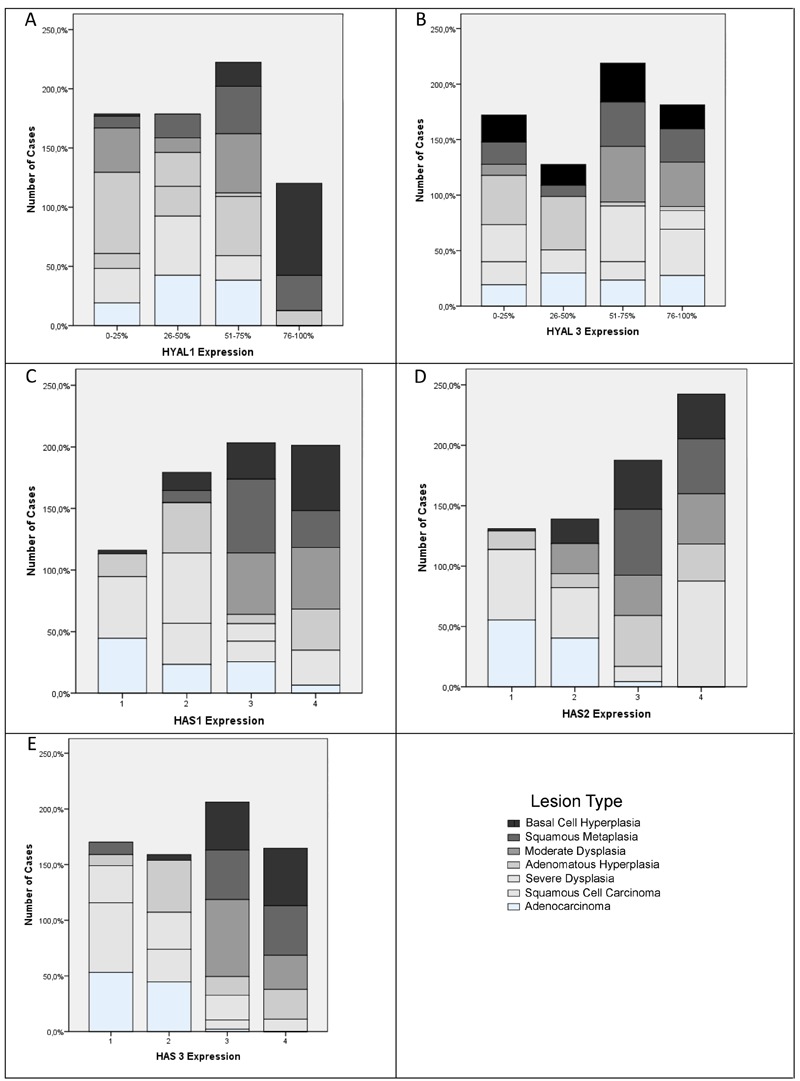
Intensity and coverage of Hyal-1 and −3 and HAS-1, −2, and −3 staining in
pre-neoplastic, squamous cell carcinoma and adenocarcinoma. See Results section
for complete information about statistical comparisons (ANOVA).